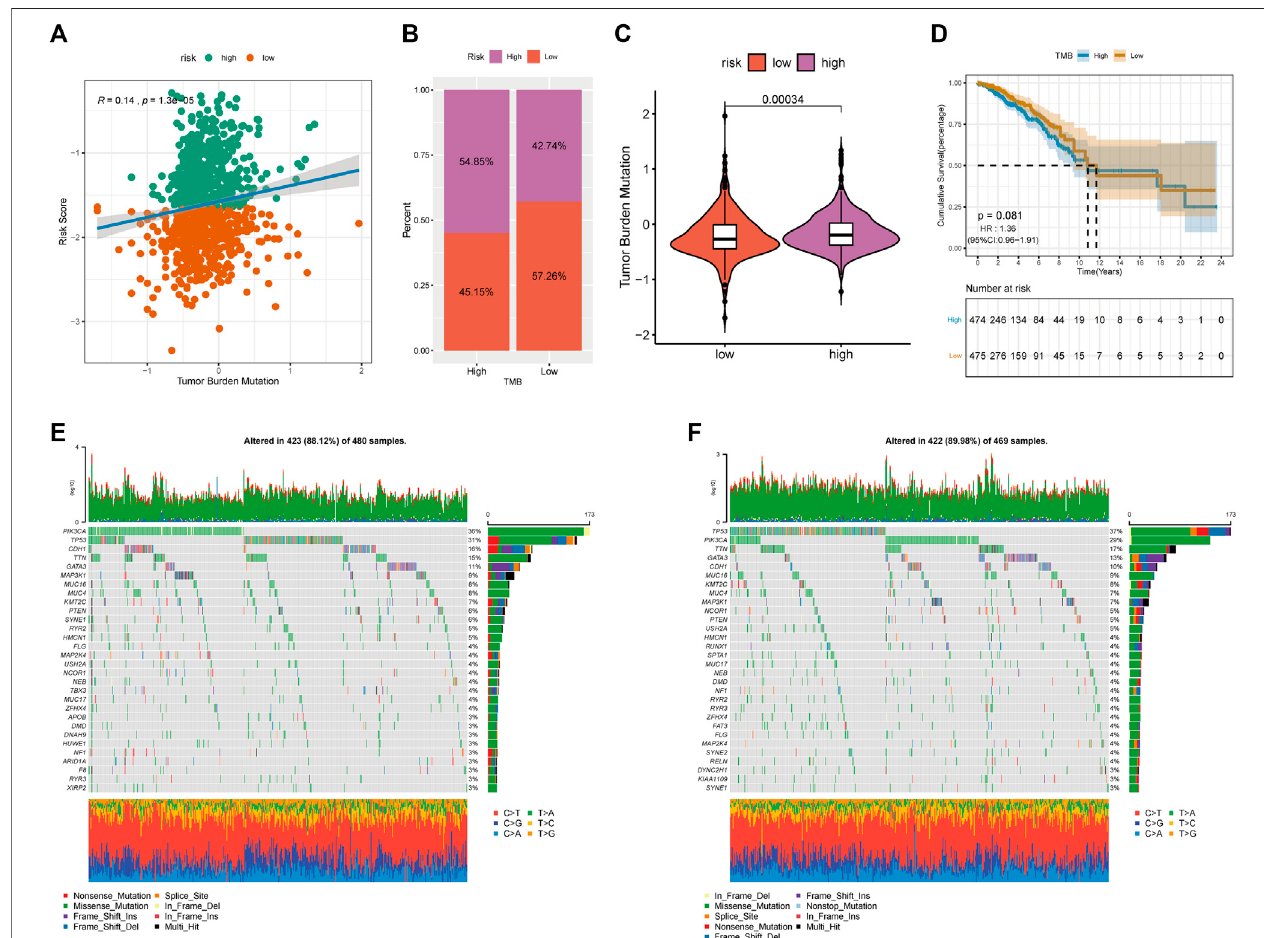
FIGURE 9| Relationship between tumor risk score and tumor mutation burden. (A) : correlation linear regression analysis; (B) : bar graph of proportion distribution; (C) : violin plot; (D) : survival curve; (E) : waterfall plot of gene mutation in low risk group; (F) : waterfall plot of gene mutation in high risk group.